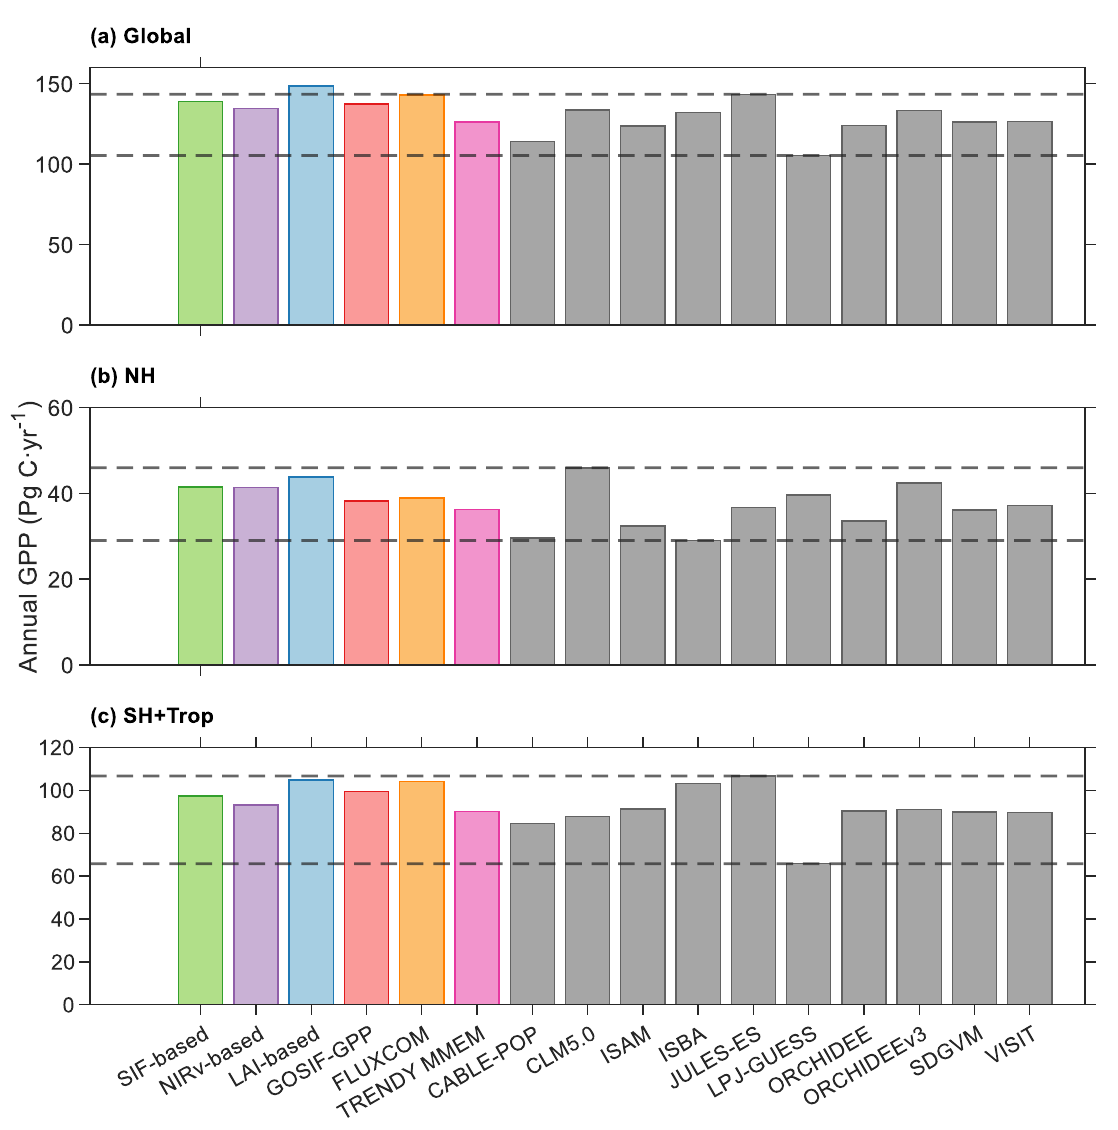
Figure 4. Comparisons of annual mean GPP among different GPP products. Global land is divided into the northern hemisphere (NH: 30 ◦ N–90 ◦ N) and tropical and southern hemisphere (SH+Trop: 90 ◦ S–30 ◦ N). The SIF-based, NIR v -based, and LAI-based labels represent the GPP estimates based on each vegetation index with optimal configurations. The dashed lines represent the maximum and minimum values of the ten processed models in the TRENDY group (‘S3’ scenarios). TRENDY MMEM represents the average of the multi-model ensemble mean.